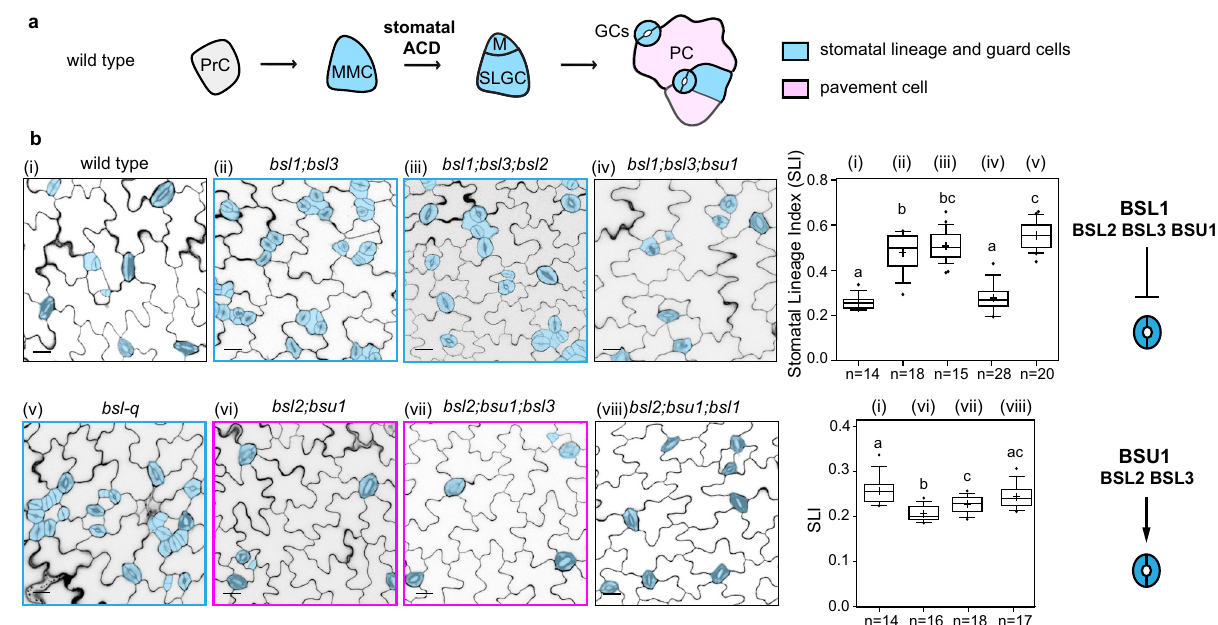
Fig. 1 Opposing regulation of BSL genes in stomatal development. a Schematic diagrams to describe stomatal development in Arabidopsis . PrC (Protodermal Cell), MMC (Meristemoid Mother Cell), M (Meristemoid), SLGC (Stomatal Lineage Ground Cell), GCs (Guard Cells), and PC (Pavement Cell). Blue shade, stomatal lineage, and guard cells; Pink shade, non-stomatal pavement cells. b Left: (i – viii) Confocal images show stomatal phenotypes in adaxial cotyledon epidermis of a 5-dpg (day post germination) wild-type or a bsl mutant plant. Stomatal lineage and guard cells are manually traced (blue). Scale bars, 20 μ m. Blue boxes highlight the genotypes producing more stomatal lineage cells and pink boxes highlight the genotypes producing fewer stomatal lineage cells. Middle: Plot boxes show Stomatal Lineage Index (# stomata lineages relative to # total cells) of the designated genotypes. Box plot shows fi rst and third quartiles, median (line), and mean (cross). Letters were assigned by ANOVA and Tukey ’ s multiple comparison test ( P ≤ 0.01). Exact P values obtained by unpaired t -test are 7.58 e − 10 for i vs . ii, 7.569 e − 20 for i vs . iii, 0.2435 for i vs . iv, 5.165 e − 18 for i vs . v, 1.77718 e − 05 for i vs . vi, 0.0045948 for i vs . vii, 0.2213566 for i vs . viii, 0.2179877 for ii vs . iii, 9.5308 e − 09 for ii vs . iv, 0.003676 for ii vs . v, 0.01535 for iii vs . v, 0.0014766 for vi vs . vii, 1.33323 e − 05 for vi vs . viii, 0.0336666 for vii vs . viii. n , number of cotyledons used for quanti fi cation of each genetic background. Right: Graphics describe differential regulation of the BSL genes in stomatal development. A complete panel of bsl mutant analysis can be found in Supplementary Fig.